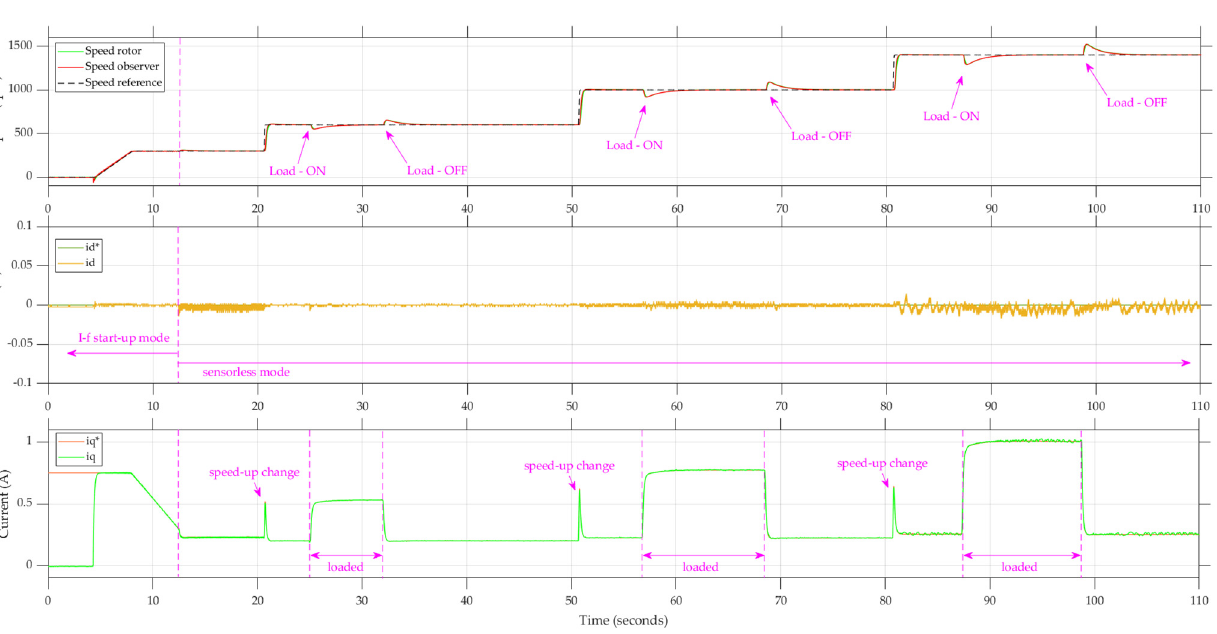
Figure 18. Experimental results for speed feedback generated by the proposed observer.